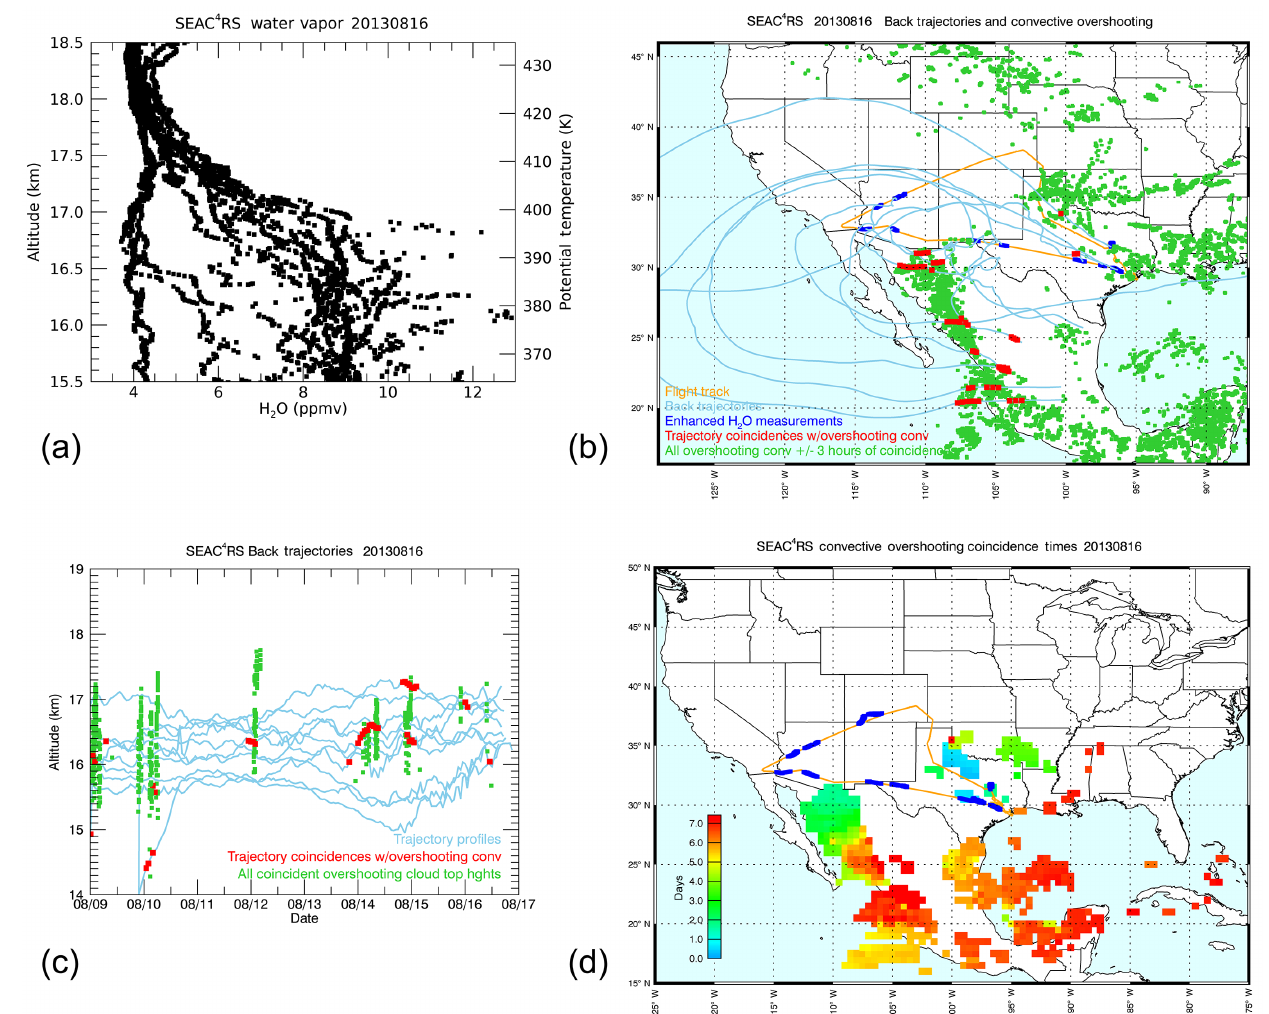
Figure 7. An analysis of the 16 August 2013 NASA ER-2 flight. (a) Vertical profiles of JLH Mark2 in situ H 2 O; similar to Fig. 6a. (b) Back trajectories from the aircraft path; similar to Fig. 6b. (c) Altitude plot of back trajectories showing coincident overshooting (red) and all overshooting within ± 3h (green); similar to Fig. 6c. (d) Days between OT and intercept by the aircraft; similar to Fig.